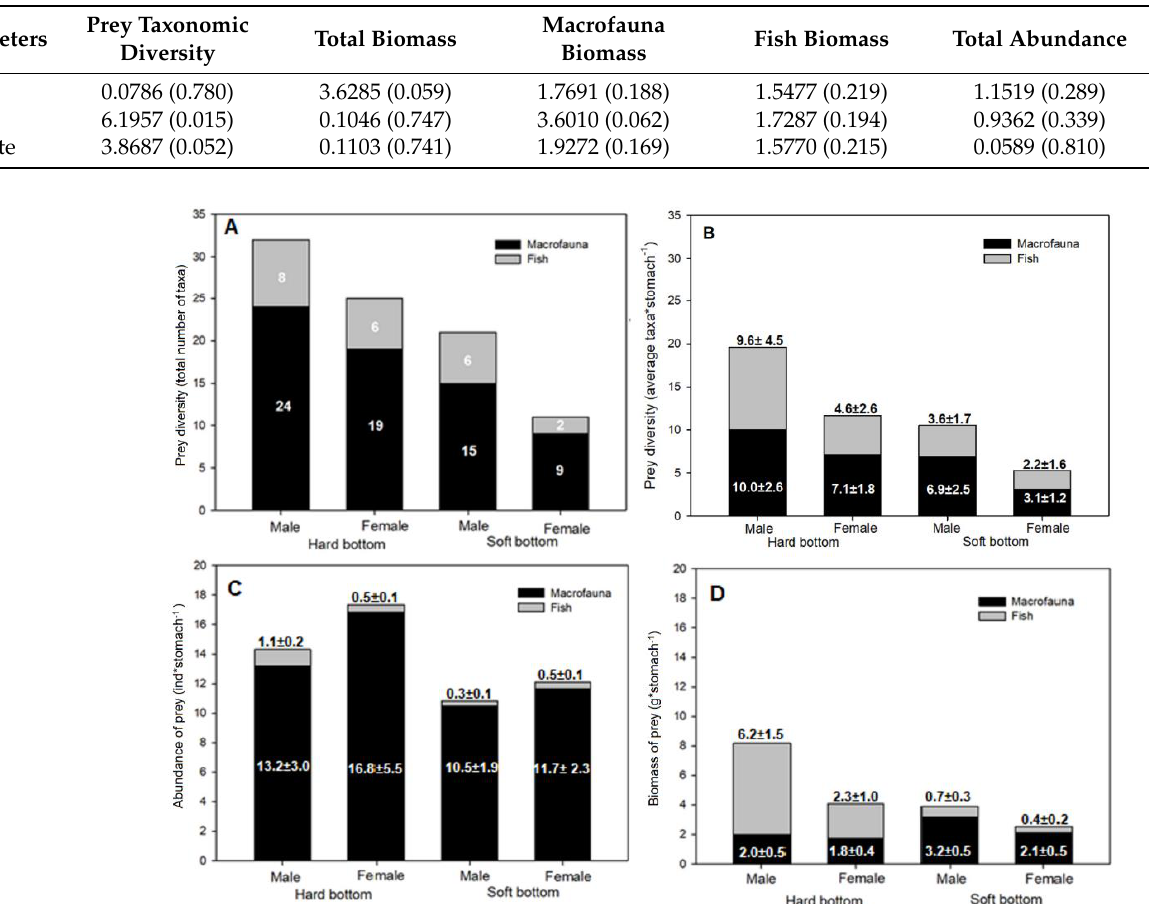
Table 3. Numerical outputs (criteria values and p -values in brackets) of robust ANOVA with trimmed means for different prey characteristics.